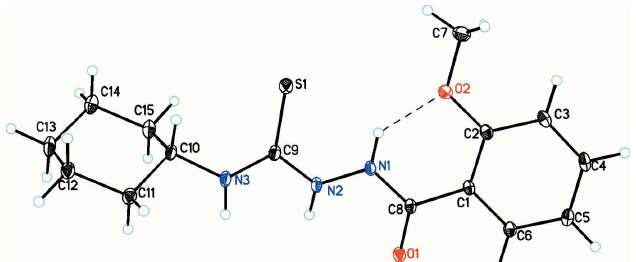
Figure 1 The molecular structure of the title compound, with atom labelling and displacement ellipsoids drawn at the 30% probability level. The intramolecular N—H (cid:2)(cid:2)(cid:2) O hydrogen bond is shown as a dashed line (see Table 1).